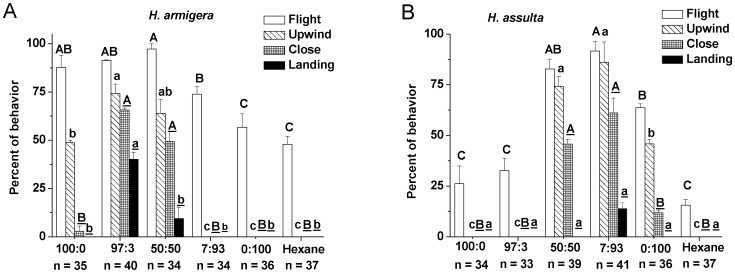
Behavioral responses of males to binary mixtures at different ratios.
A, H. armigera; B, H. assulta. Ratios of the two compounds are Z11–16: Ald to Z9–16: Ald. Values are mean ± SEM. Symbols in the same behavioral category having no same letters are significantly different (Chi-square test, P<0.05).